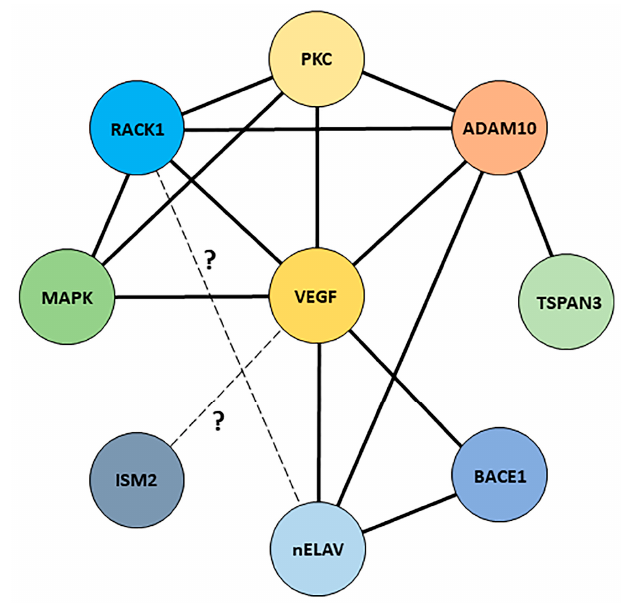
Figure 7. Putative sAPP α -related VEGF-RACK1 neuroprotective interaction network. RACK1 has been demonstrated to play pivotal roles in neuronal context and its modulation has been observed to be influenced by sAPP α treatment. Therefore, considering the reported and putative interactions among RACK1 and several players here discussed, it is possible to hypothesise a molecular network correlated to sAPP α and with potential implications in both AD and TBI context, from both a biological and pharmacological point of view ( bold lines = protein-protein interactions or protein functional correlations reported in literature and cited in the text; dash lines = putative structural and/or functional protein correlations hypothesised based on available literature data).